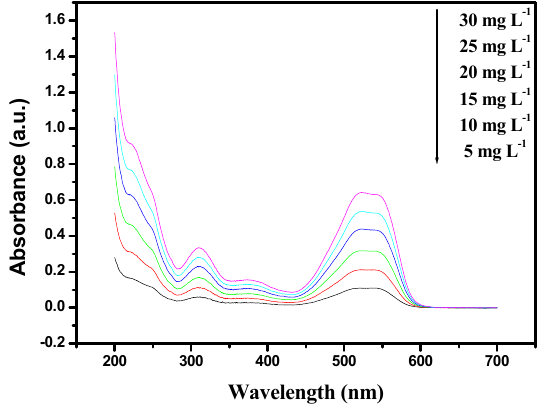
Figure 10. UV-Vis absorption spectra of different concentrations of AG.